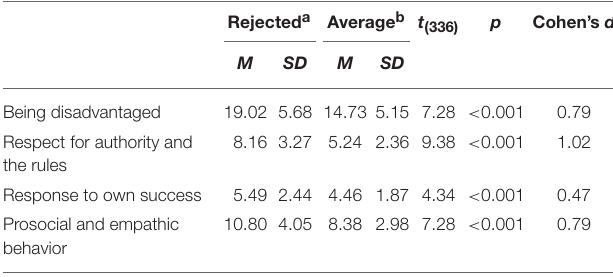
TABLE 8 | Group differences for factor scores between rejected or average sociometric